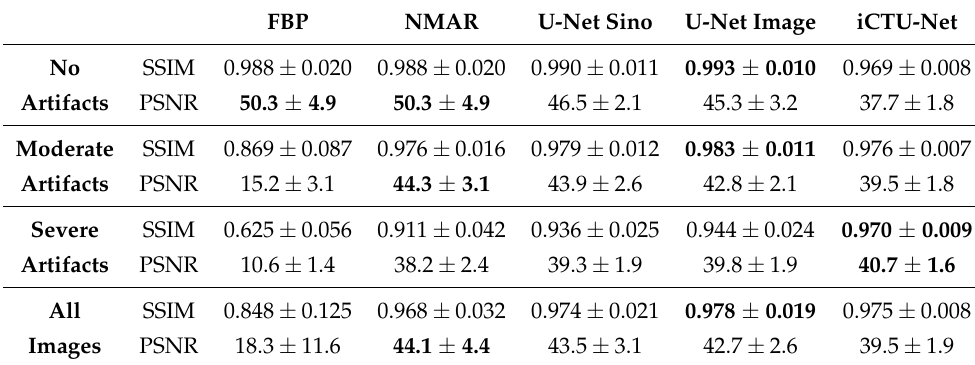
Table 3. SSIM and PSNR evaluation metrics for the comparison study. The best result for each metric is marked bold